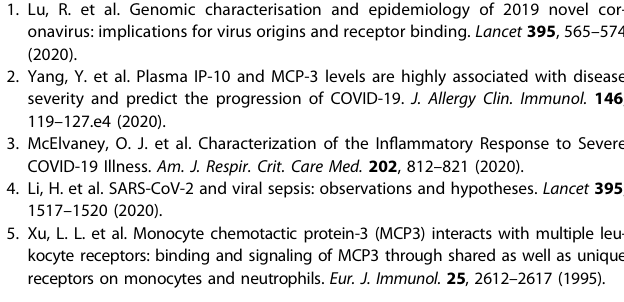
Fig. 1 MCP-3/IL-8 scores were correlated with ICU admission and fatal outcomes. a Unsupervised clustering analysis of average baseline- adjusted and log2-transformed fold changes in cytokines in COVID-19 infected patients needing ICU admission, sepsis patients, and patients experiencing CRS after receiving CAR-T cell therapy. The 39 cytokines/chemokines presented overlap in all three sets of data. C-ICU, COVID-19 patients in ICU wards; sepsis, bacterial septicemia patients. b The most signi fi cant predictors for ICU admission were identi fi ed by random forest modeling. Relative variable importance is illustrated. c LASSO regression identi fi ed 10 analytes that contributed to distinguishing ICU patients from non-ICU patients. The coef fi cients are shown. Red bars and green bars represent cytokines positively and negatively contributing to the lasso regression model, respectively. d Venn diagram results for the random forest and lasso modeling are shown. *chemokines. e Receiver operating characteristic (ROC) curve evaluation of the performance of immune scores in identifying COVID-19 patients needing ICU admission in the internal test set. f Comparison of immune scores between the non-ICU and ICU patients in training and internal test sets. The arrows indicate patients who were transferred to ICU wards during the follow-up period. r, Spearman ’ s correlation coef fi cient. g ROC curve evaluation of the performance of immune scores in identifying COVID-19 patients needing ICU admission in the external test set. h Comparison of immune scores between the non-ICU and ICU patients in the external test sets. i Spearman ’ s